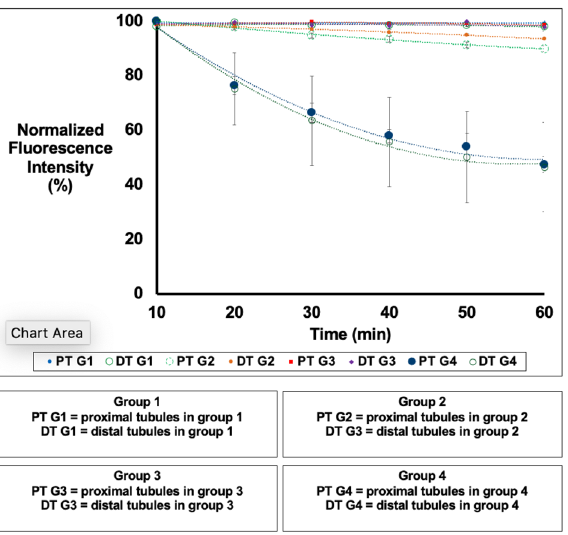
Figure 7. In vivo changes in mean fluorescence intensities obtained from proximal and distal tubular segments. There were no considerable differences in fluorescence intensity recorded from proximal and distal